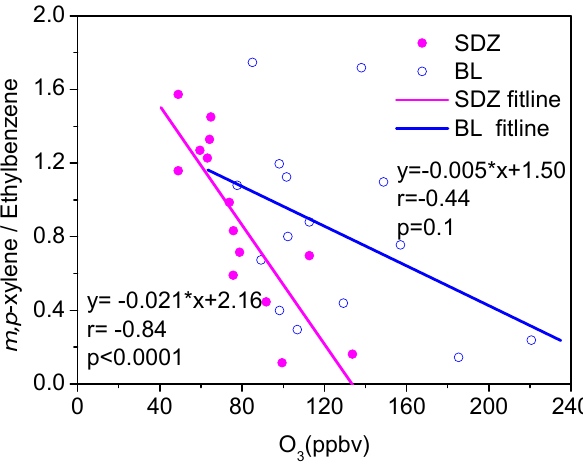
Fig. 12. Scatter plots of m,p -Xylene/ethylbenzene ratio to O 3 Fig.12. Scatter plots of m, p -Xylene/ethylbenzene ratio to O around photochemically active afternoon time (14:00–14:30) at BL and SDZ afternoon time (14:00 ～ 14:30) at BL and SDZ sites. 4